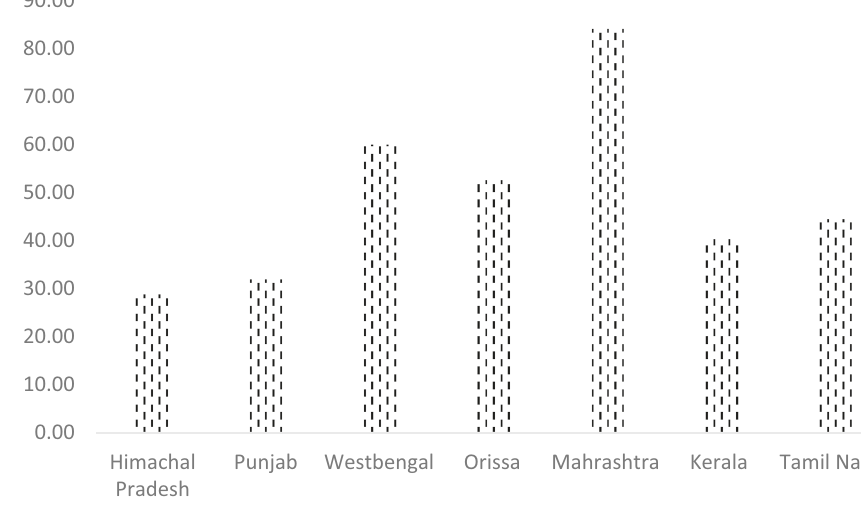
Fig. 1 Work stress prevalence by states among Older Adults in India. Authors Own Computation from the BKPAI Survey of